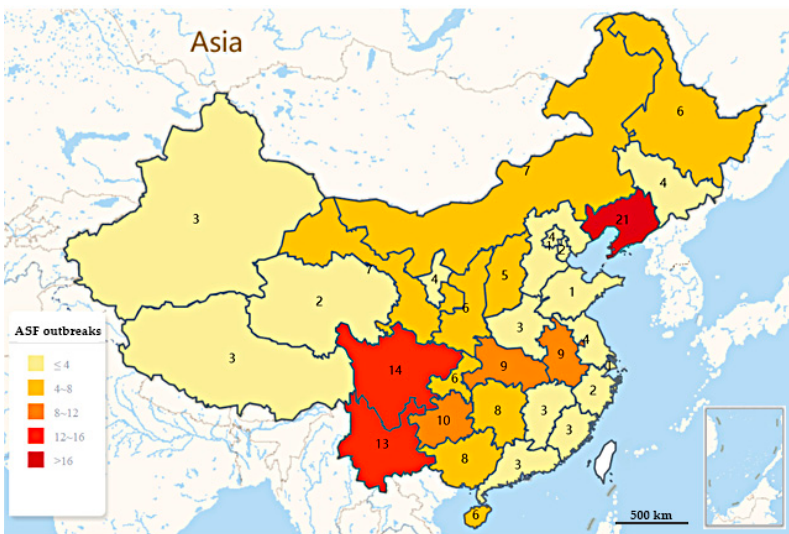
Figure 2. The distribution of ASF outbreaks in China (August 2018–July 2020). Outbreak analysis of geographical distribution showed that as of 24 July 2020, 178 outbreaks were reported in 31 provinces and geographical regions of China (Figure 2), and the outbreak rates of ASF in each province are shown in Table 1. Comparison of the provinces showed that the spread tendency of the outbreaks is mainly concentrated on the northeast and southwest regions, and the trend is increasing southward [18]. Table 1. The distribution of ASF outbreaks in China, August 2018–July 2020. No. of No. of No. of Region Provinces Outbreaks Susceptible Incidence